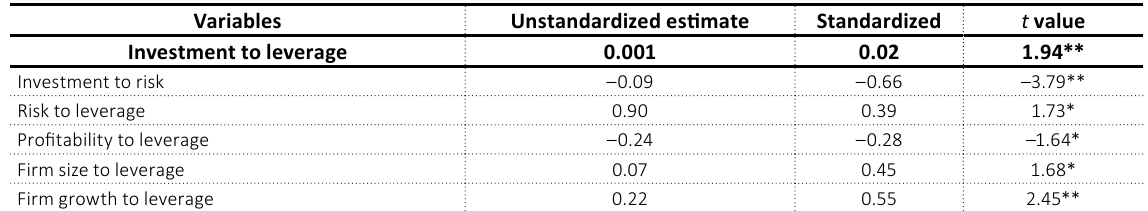
Figure 1. Path diagram Table 3. The direct influence of profitability, risk, firm growth, investment, firm size and leverage Source: The result of data processing by LISREL.